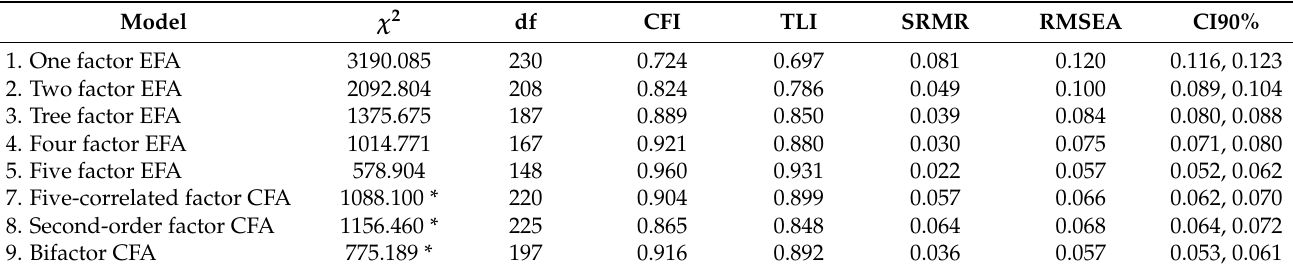
Table 1. Psychometric proprieties of the tested models.